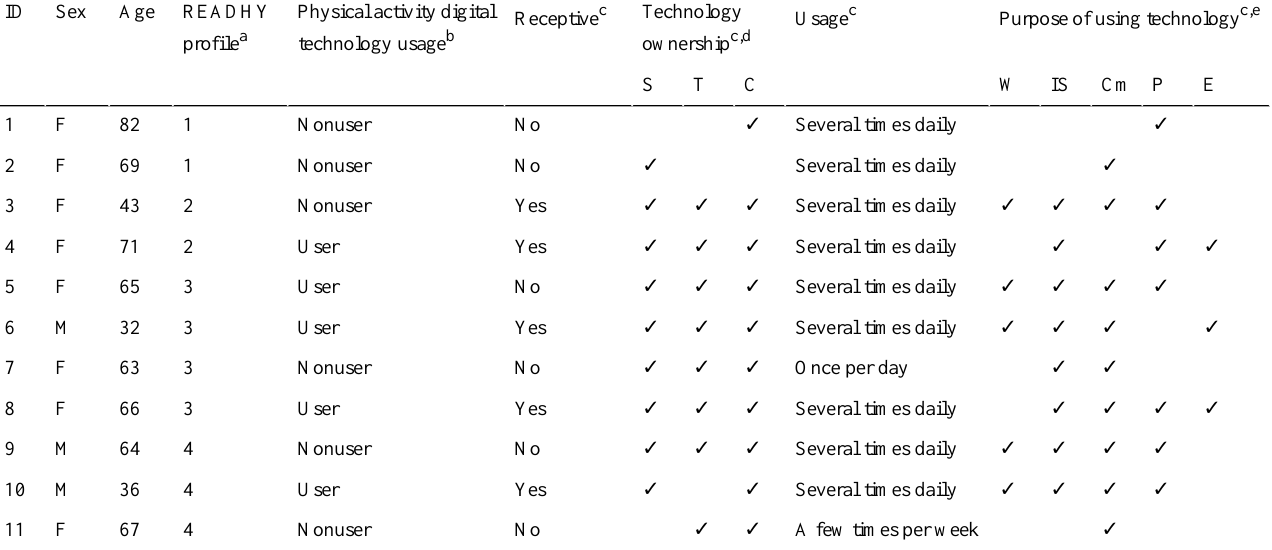
Table 1. Characteristics of interview